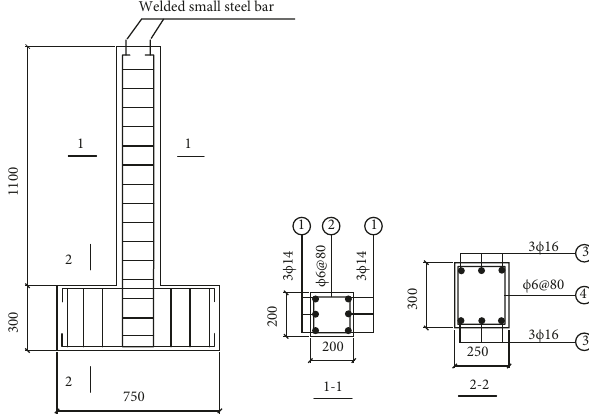
Figure 4: Details of test specimen (unit: